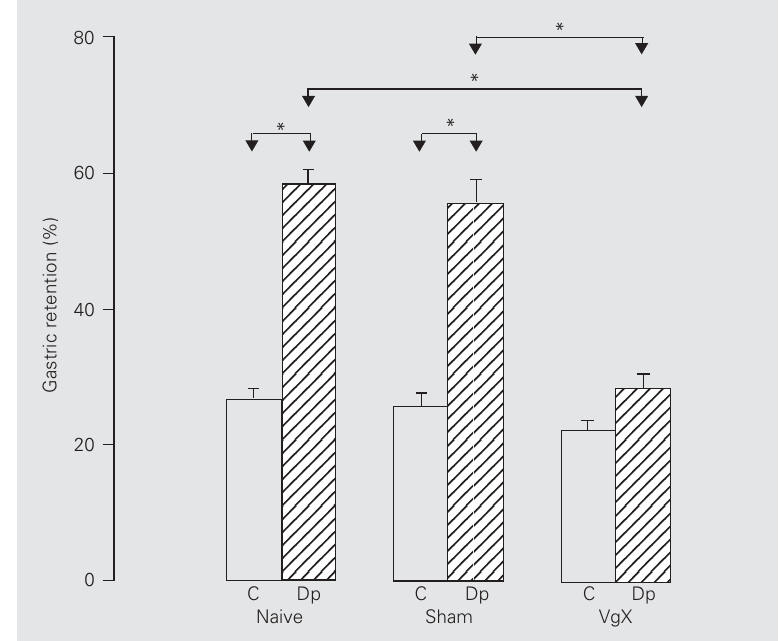
Figure 3. Gastric retention (%), reported as mean ± SEM, of a saline test meal determined 10 min after administration to rats by gavage. Two weeks before the procedure, the animals were submitted to sham surgery (Sham) or subdiaphragmatic vagotomy (VgX). The animals in the Naive group were not submitted to any procedure. The rats (N = 8) of each group received iv vehicle (C) or 80 mg/kg dipyrone (Dp) 30 min before the determination of gastric retention. *P < 0.01 for the comparisons indicated by the arrows (Tukey